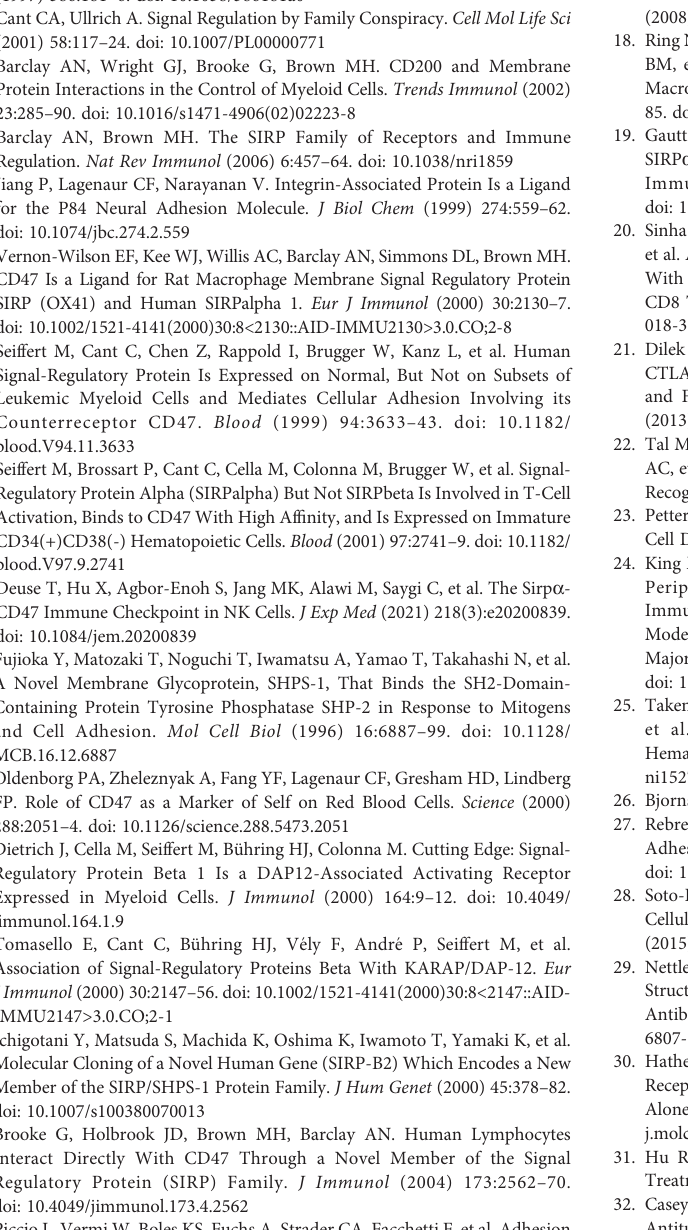
CD45RA − CD27 − effector memorycells (EM), CD45RA − CD27 + central memory